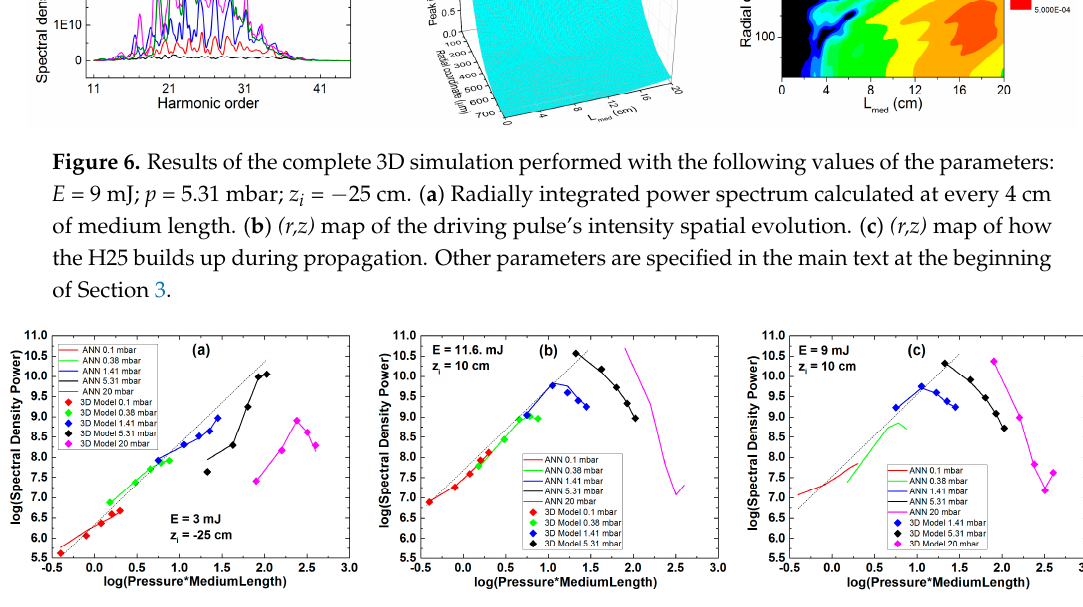
Figure 7. Harmonic yield as function of the optical density of the medium. We represent the logarithm of both quantities, the units are arbitrary. Slope = 2 indicates the quadratic growth of the harmonic yield with the optical density.